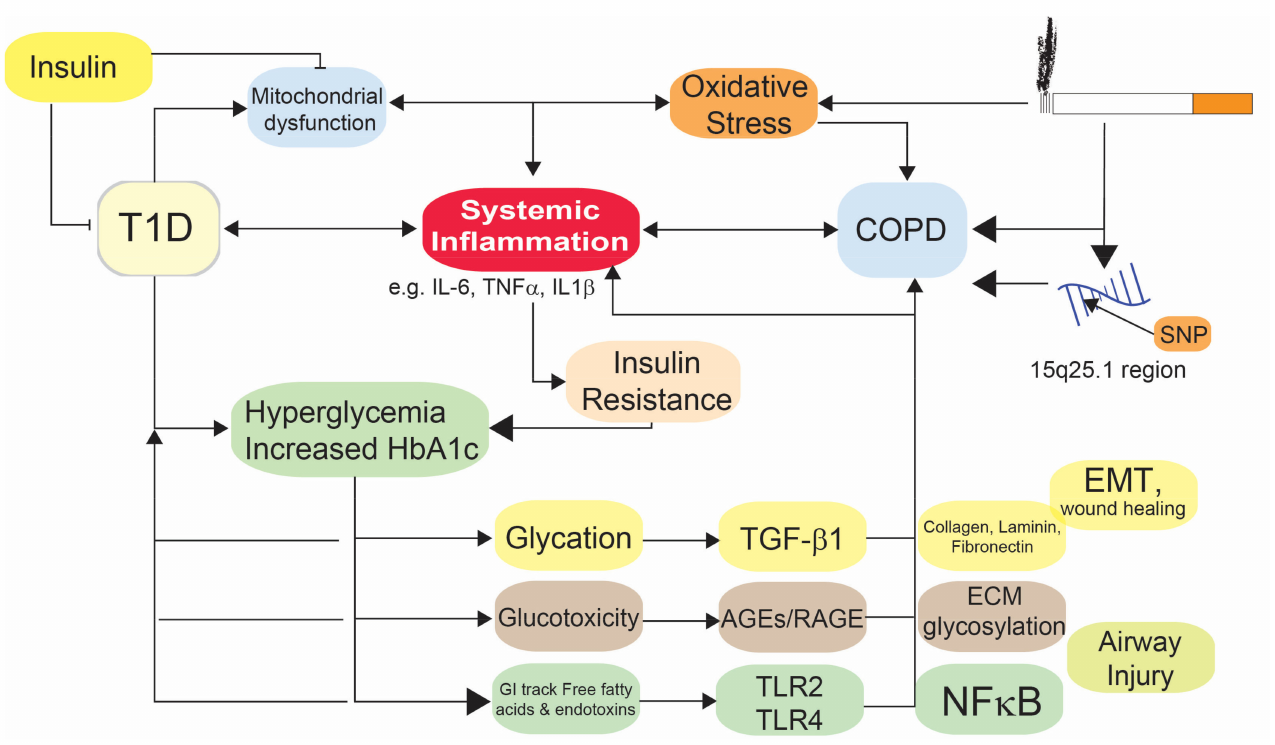
Figure 1. Possible mechanisms resulting in the increased prevalence of T1D in